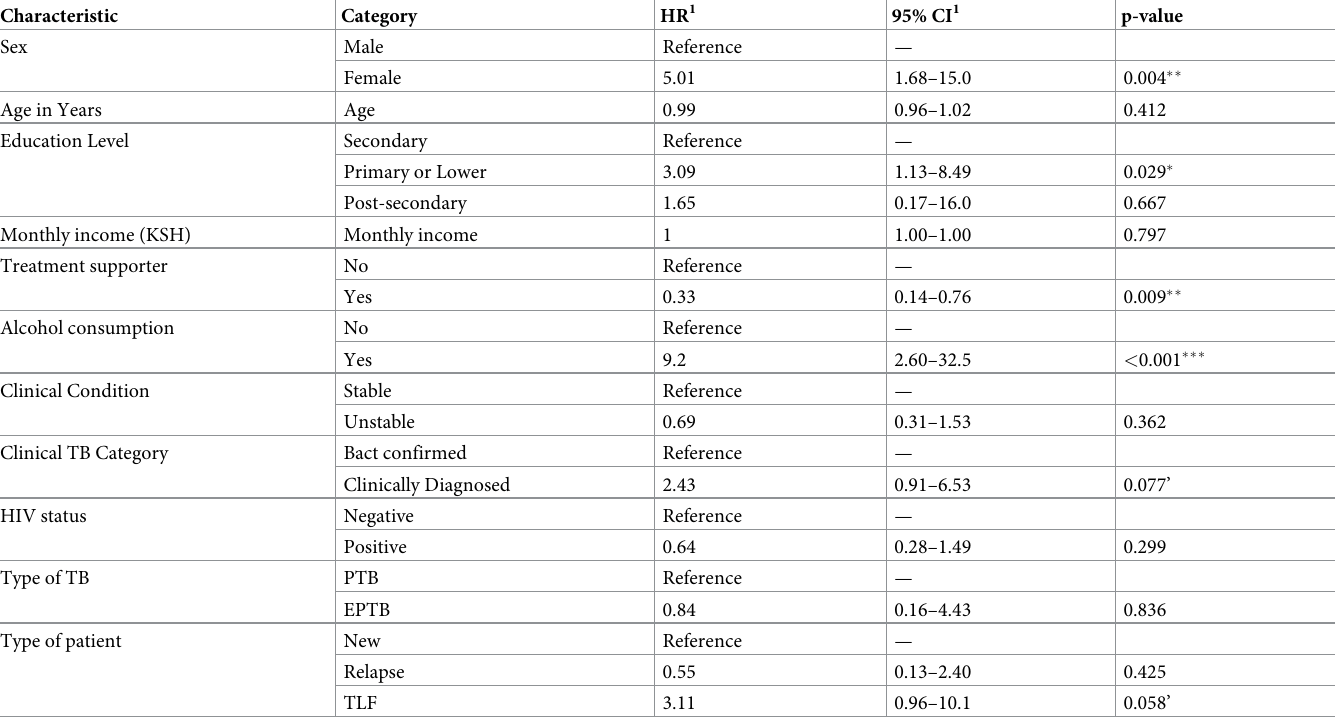
Table 3. Multivariable Cox regression analysis of predictors of TB treatment interruption among patients treated for TB in Vihiga County.